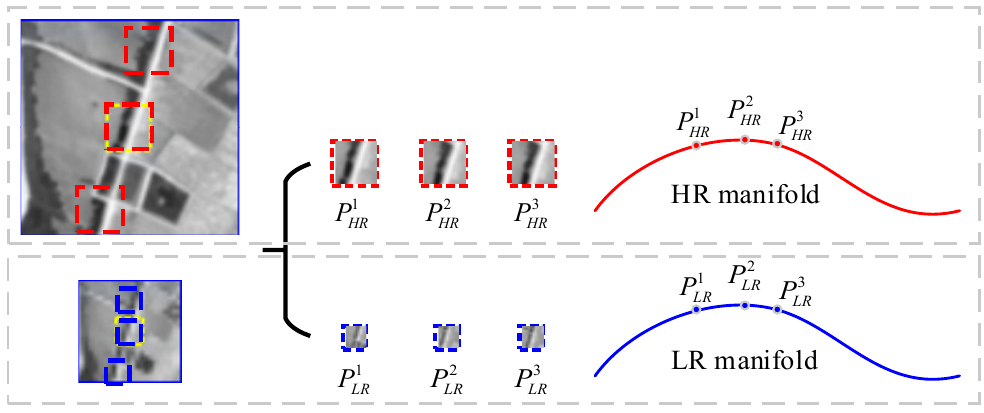
Figure 3. The manifold of HR and LR patches.